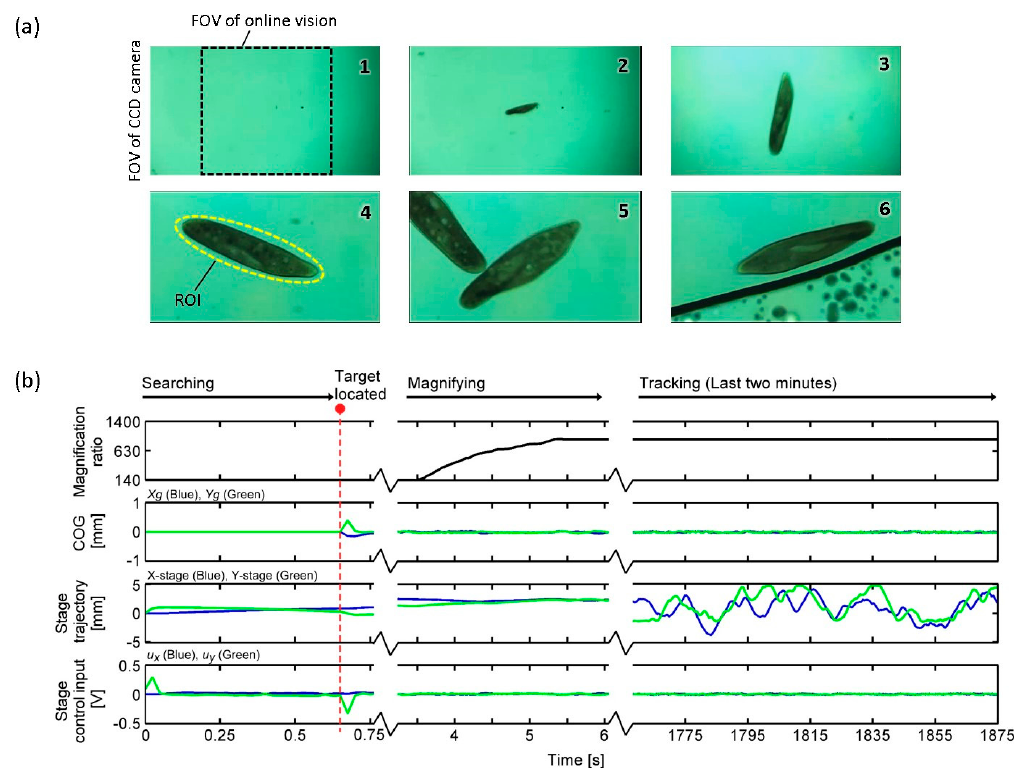
Figure 9. Results of long-time tracking of single Paramecium in a microfluidic chip. ( a ) Images of all tracking procedures; ( b ) Data log measured by the developed platform during the target tracking experiment (data sampling cycle was 10 ms).